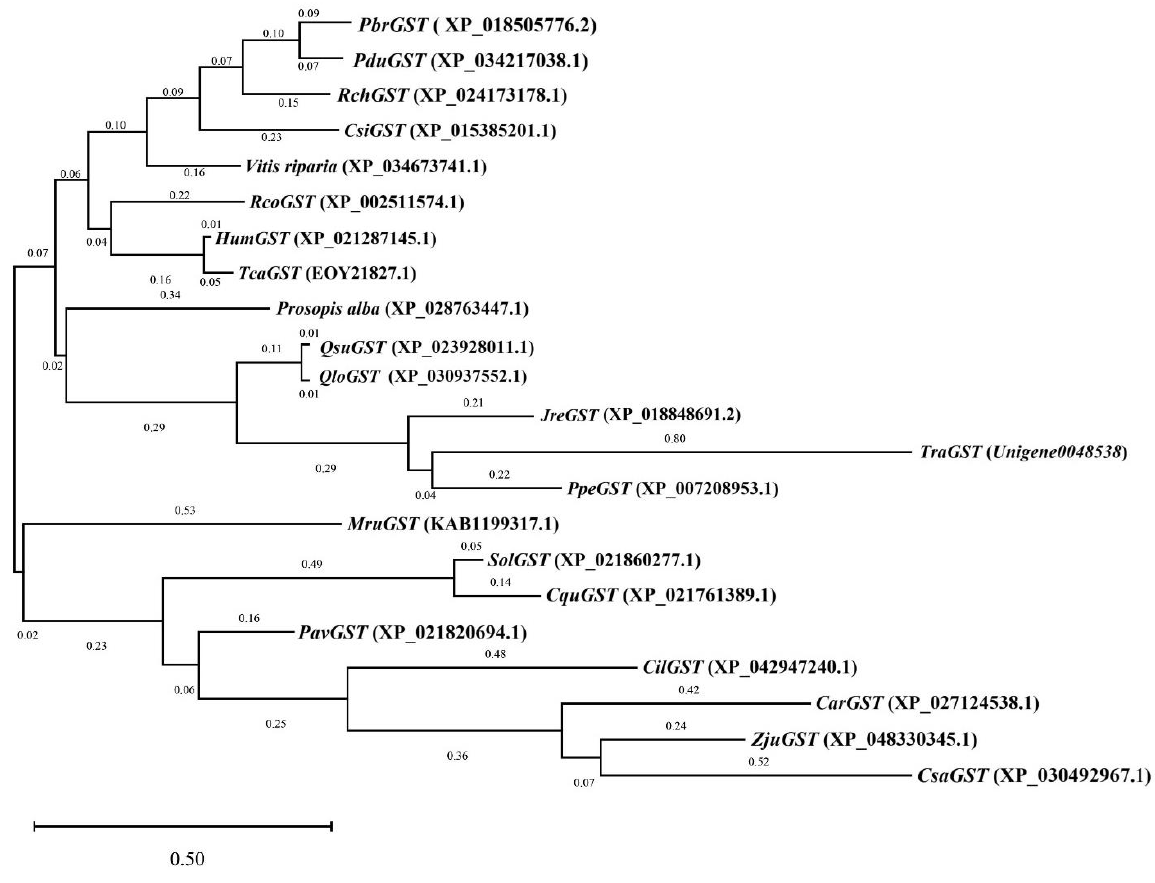
Figure 6. Phylogenetic tree analysis of T . ramosissima GST and other species GST. Phylogenetic tree analysis of Unigene0048538 protein amino acid sequence and protein amino acid sequence of other 21 species of T . ramosissima.